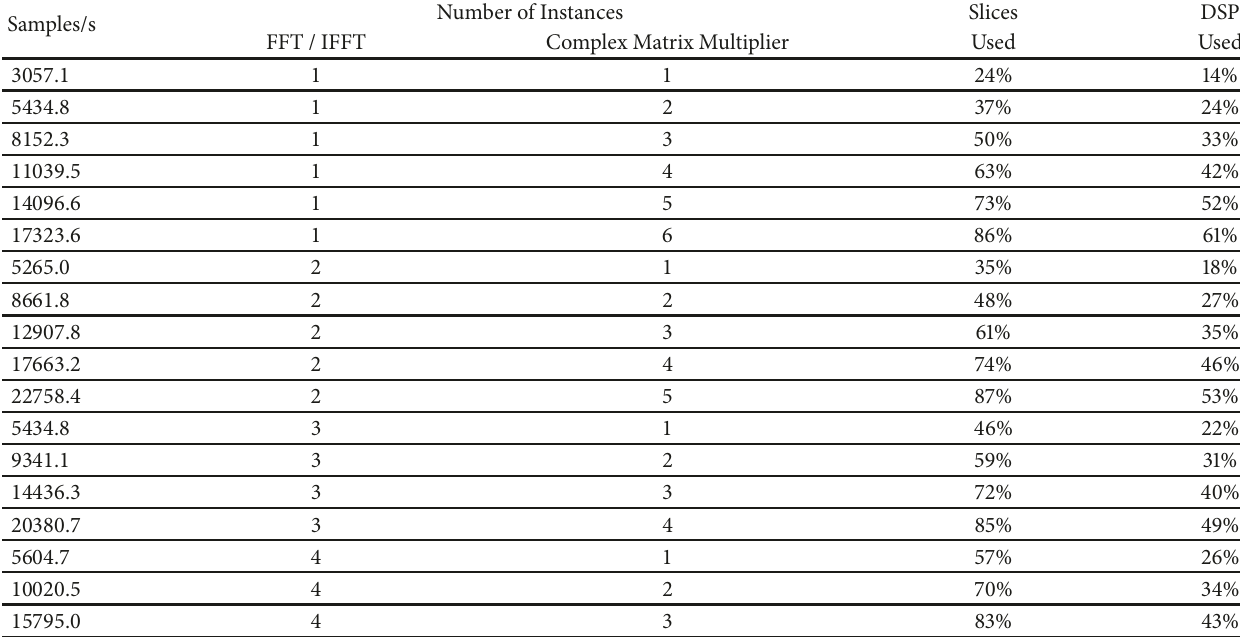
Table 4: Maximum speedup with multiple instances in the FPGA